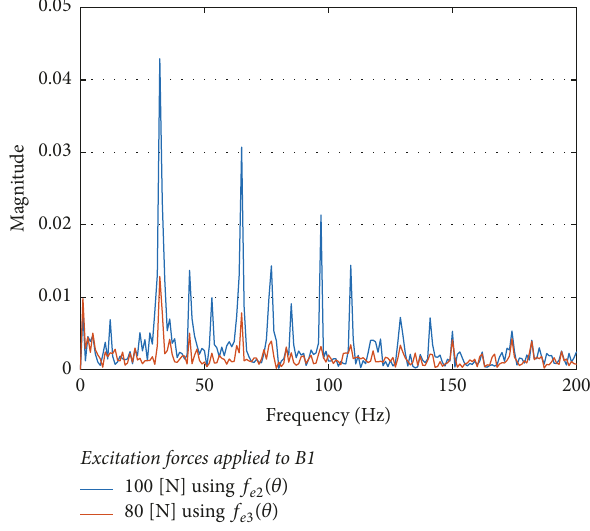
Figure 19: Envelope spectrums for two various